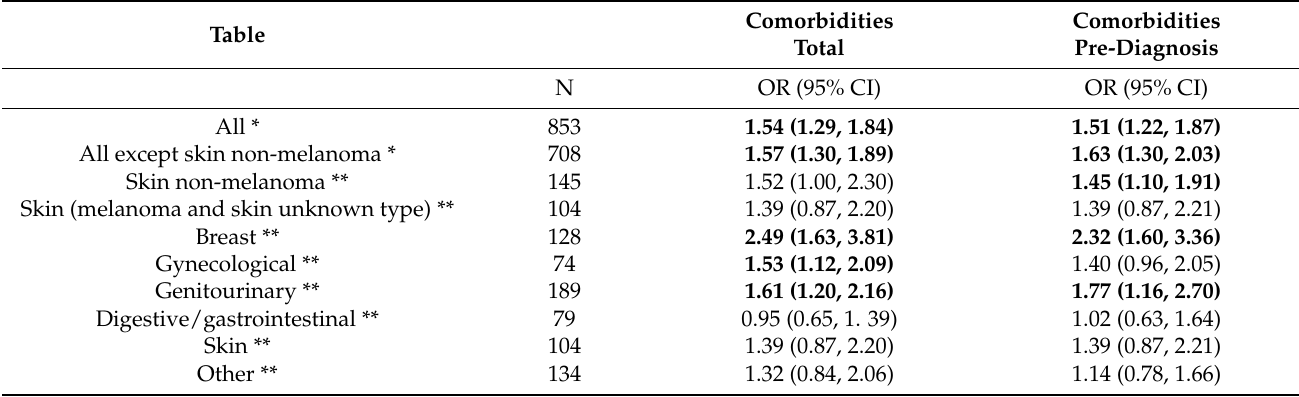
Table 3. Effect of comorbidities on depression (PHQ-9 ≥ 10) overall and according to cancer site in recent cancer survivors (n = 853). Table